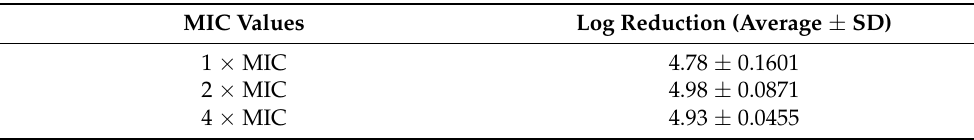
Figure 1. Time-killing profiles of r-javanicin against C. neoformans . ( a ) cell viability was determined by colony count and expressed in log 10 CFU/mL versus time. The error bars and standard deviation were represented in three independent experiments and performed in triplicate. ( b ) the percent inhibition calculated during fungal cells growth in the presence of various concentrations of r-javanicin compared with untreated cells was illustrated. Table 1. Antimicrobial effectiveness of r-javanicin against C. neoformans expressed in log CFU/mL reduction